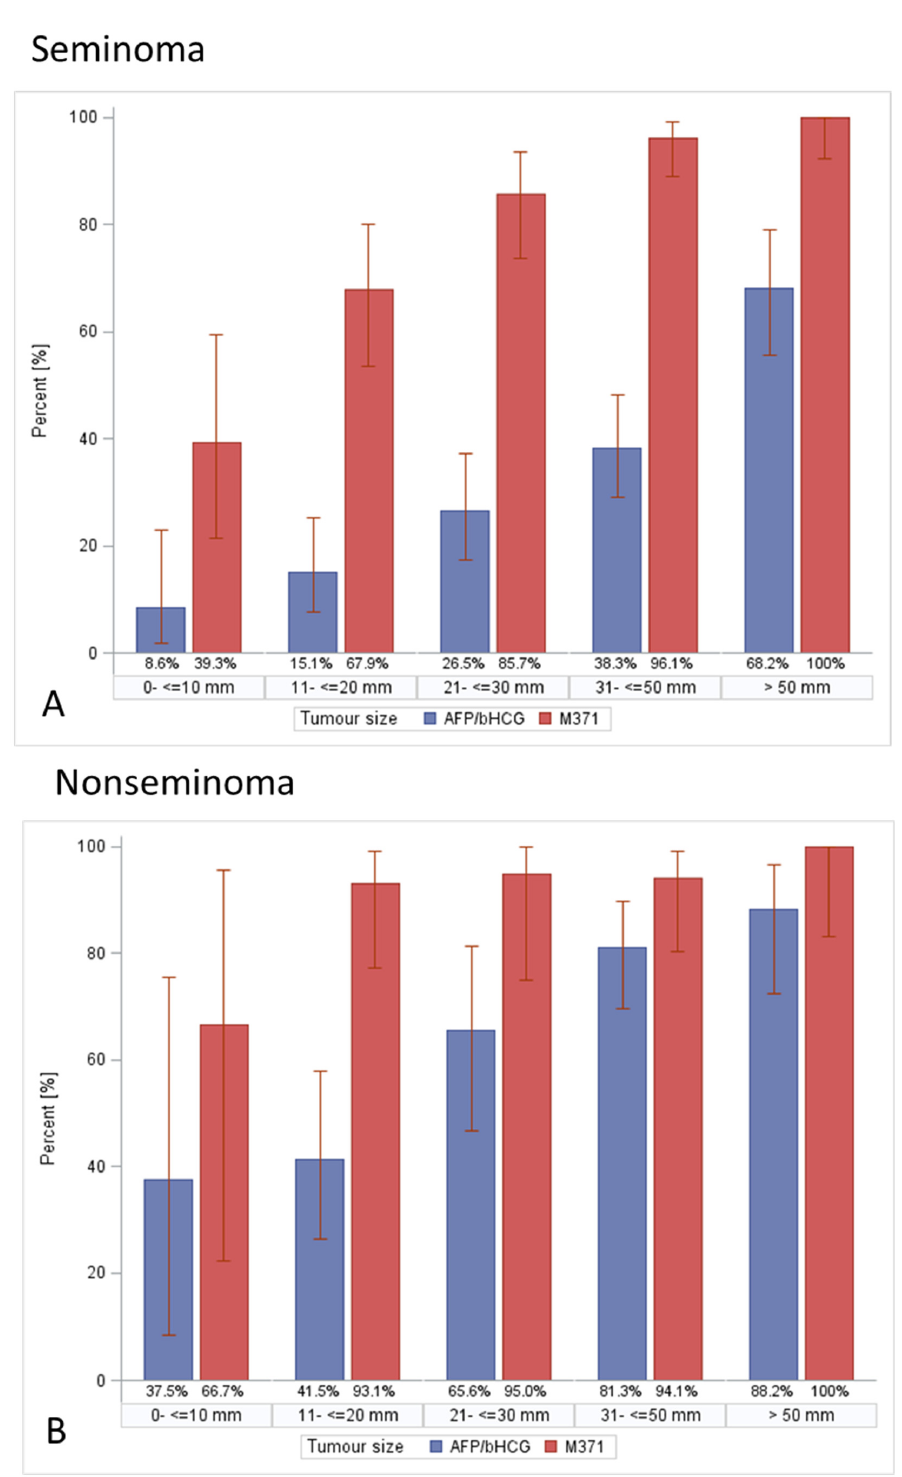
Figure 7. Expression rates of M371 and AFP and/or bHCG in germ cell tumours in relation to size of primary tumour in seminoma ( A ) and in nonseminoma ( B ). Blue columns denote expression rates of AFP and/or bHCG in five categories of tumour size, red columns indicate expression rates of M371. Overall, the expression rates of all tumour markers were higher in nonseminoma than in seminoma. All markers showed a significant trend towards lower expression rates with decreasing tumour size. M371 had higher expression rates than the other markers even in the smallest tumour size category. Error bars represent 95%